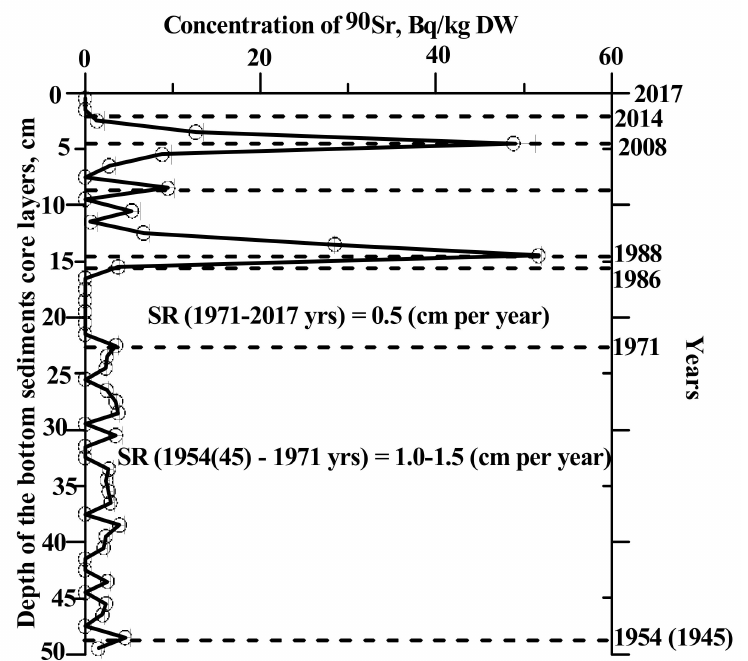
Figure 3. Dating of bottom sediments and the rate of sedimentation in Lake Aktashskoye by 90 Sr as a